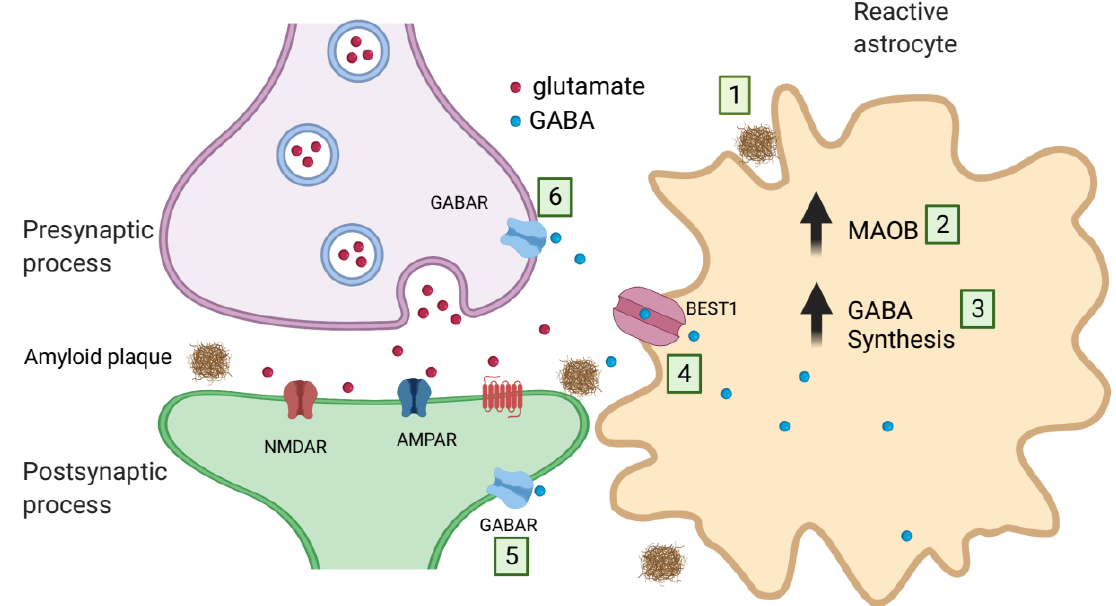
Figure 3. Schematic representation of GABA release from astrocytes in AD pathology. (1) Amyloid plaques evoke an enhanced activation of the monoamine oxidase MAOB (2) to induce the GABA synthesis using putrescine as a substrate (3). GABA is released from astrocytes via the anion channel BEST1 (4). GABA released as a gliotransmitter acts on postsynaptic (5) or presynaptic (6) GABA receptors (GABAR) to impact synaptic transmission. Arrows indicate increases.